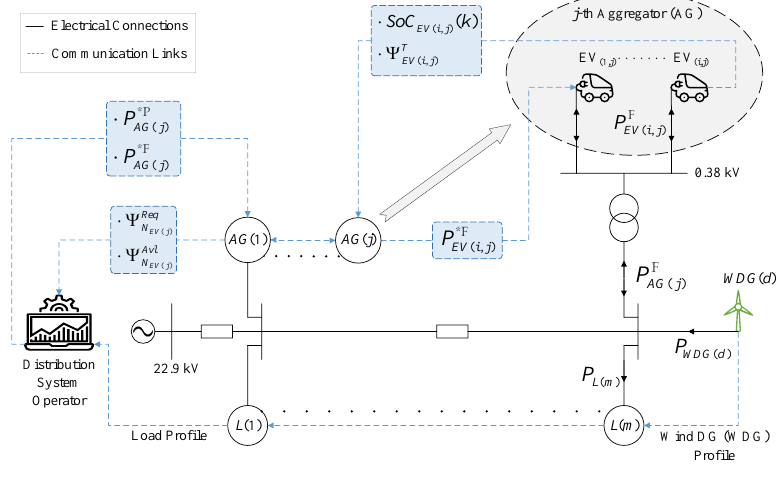
Figure 2. System